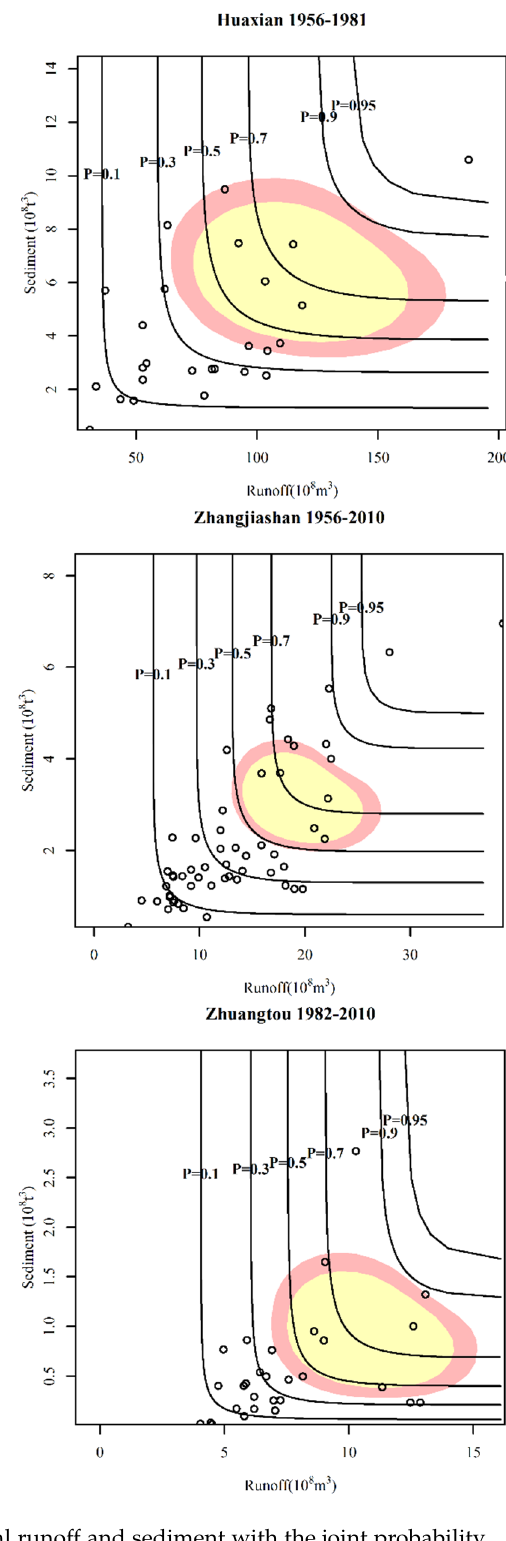
Figure 4. Uncertainty of joint probability for annual runoff and sediment with the joint probability P = 0.7 in different periods at the six gauging stations in the WRB. The colors of the filled regions indicate 95% and 99% joint confidence areas. The observed runoff and sediment data are shown as empty circles.